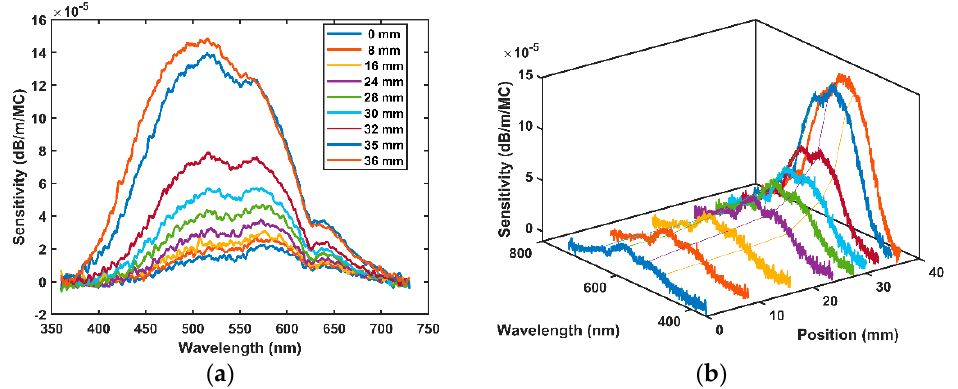
Table 4. Estimated dose conversion for the proton spectra for 10,000 MC to cGy at each position (characterization from the Markus chamber).